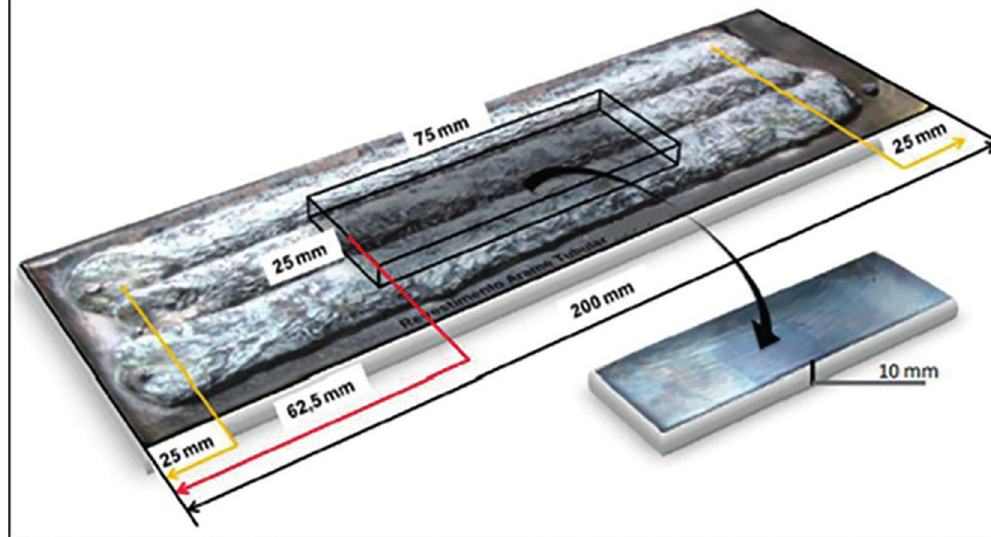
Figure 2: Scheme of the sample geometry and selected area for microhardness and wear properties tests 15 .